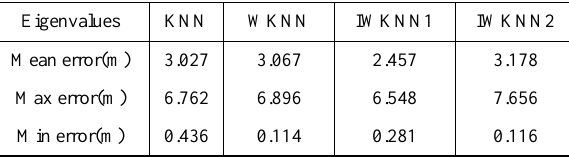
Table 4. Positioning results when using the calculated coordinates of fingerprint